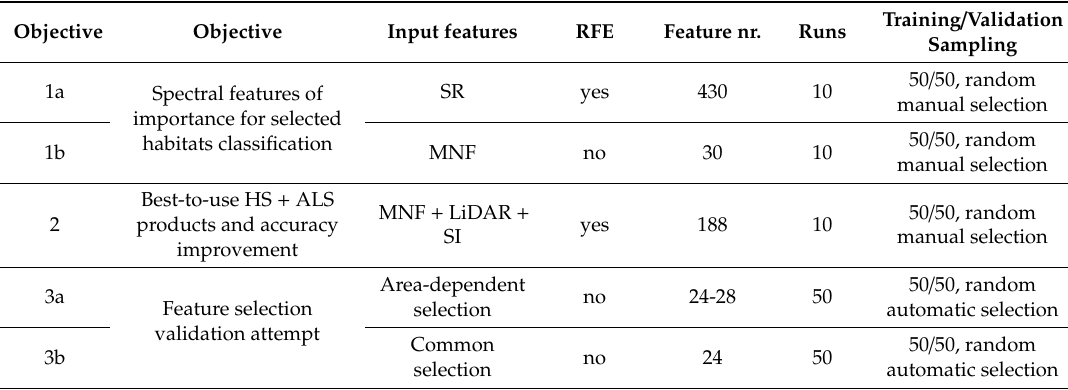
Table 2. Di ff erent experiments’